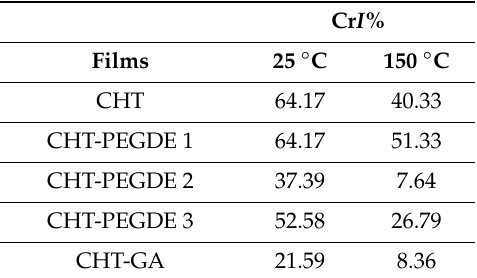
Table 3. Percentage of the crystallinity of the chitosan films without crosslinker and with crosslinker of GA and PEGDE dried at 25 ◦ C and 150 ◦